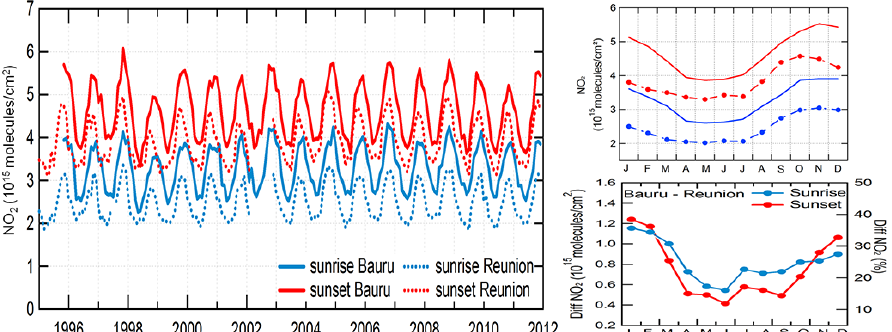
Figure 9. Left: monthly mean time series of SAOZ total NO 2 columns at sunrise (blue) and sunset (red) in Bauru (solid lines) and Reunion (dotted). Top right, seasonal variation in Bauru and Reunion. Bottom right: difference between the two stations.